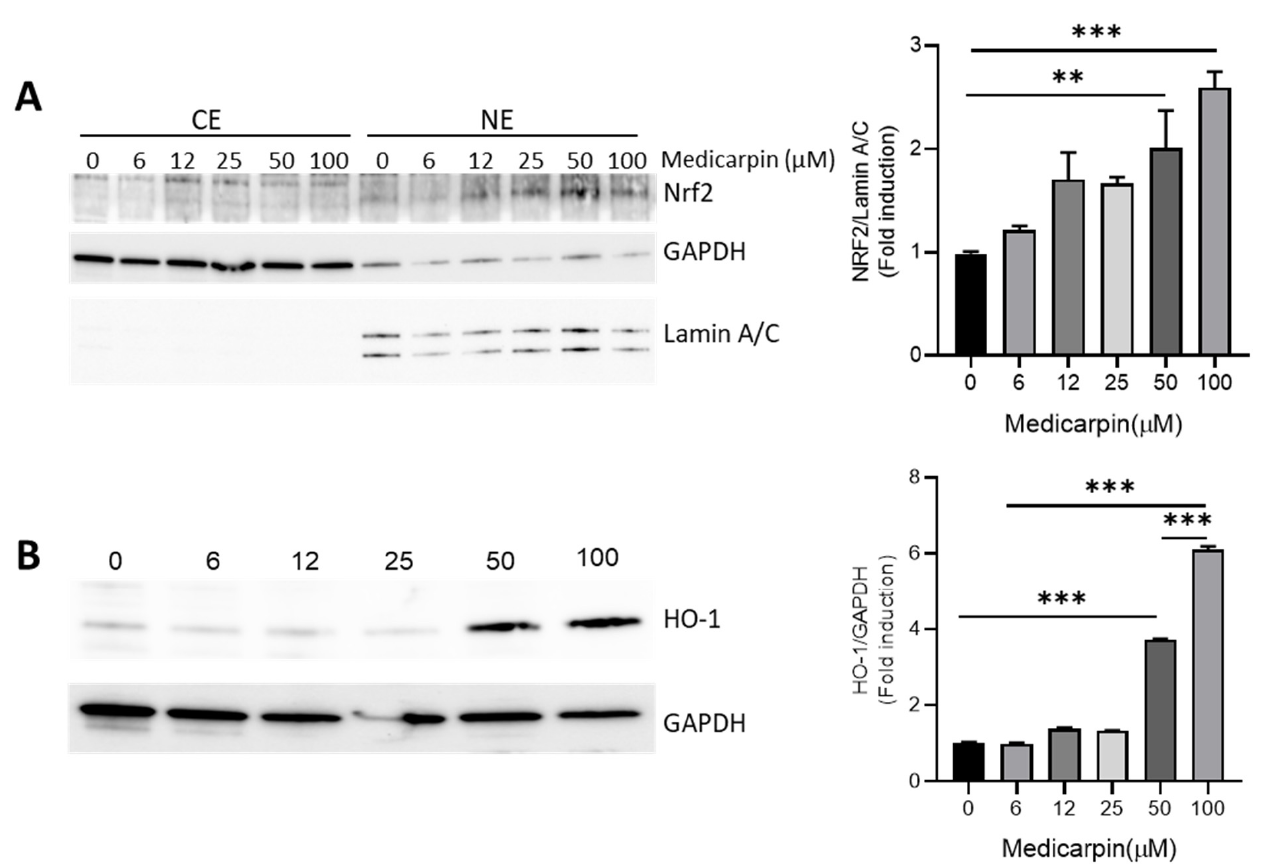
Figure 2. Medicarpin increases nuclear NRF2 accumulation, which results in HO-1 induction in HeLa cells. ( A ). Western blotting data shows nuclear NRF2 level after treatment with different concentrations of medicarpin for 6 h. The densitometrical analysis of nuclear NRF2 is shown in the right panel. ( B ). Western blot analysis using whole cell lysates shows the HO-1 level after treatment with the indicated concentration of medicarpin for 24 h. The densitometrical analysis of HO-1 is shown in the right panel. GAPDH and Lamin A/C were used as cytoplasmic and nuclear markers, respectively. CE, cytoplasmic extract; NE, nuclear extract. The experiments were repeated three times with similar results. ** p < 0.001; *** p < 0.0001.